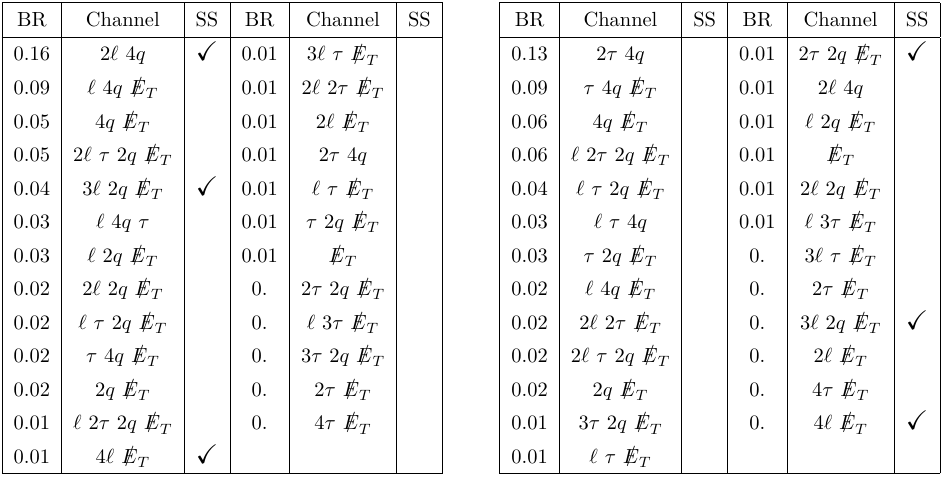
Table 3 . Decay rates from NN production for BP1 NH (left) and BP2 NH (right). The rates are obtained by summing on all charges and flavor configurations. Here ‘ = e, µ . The checkmarks correspond to channels that can produce a SS lepton signal.